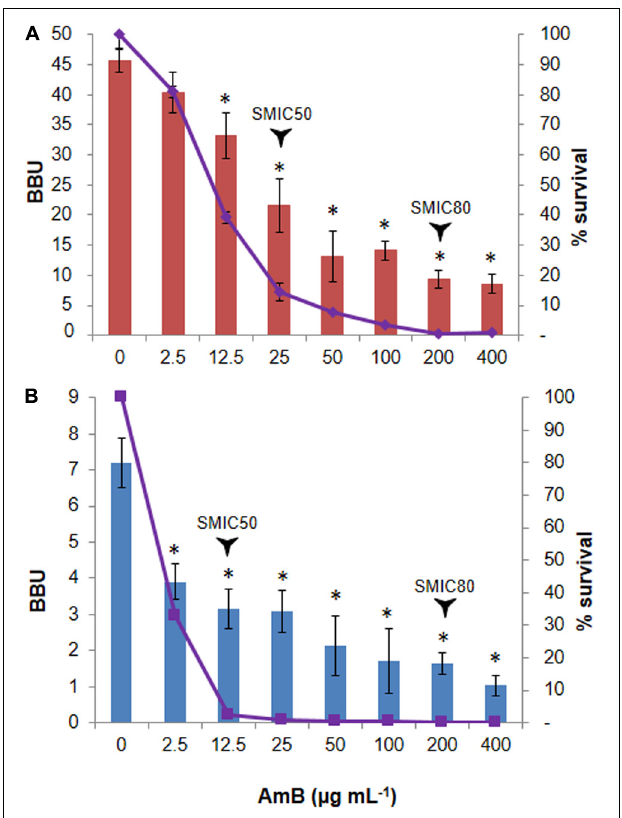
FIGURE 2 | Biphasic killing pattern in response to Amphotericin B (AmB) treatment on Candida tropicalis biofilms. The 48 h-old biofilms of the (A) reference NCPF 3111-N ◦ 1-, and (B) clinical-N ◦ 2- C. tropicalis strains were treated with 2.5–400 µ g mL − 1 AmB. The biofilm biomass units